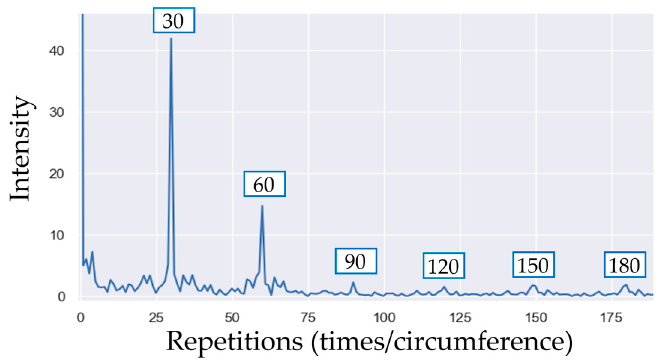
Figure 5. Fourier transform of the pseudo signal shown in Figure 4. The main peak indicates the number of teeth of the CSC (30 in the specific case of the gear wheel).